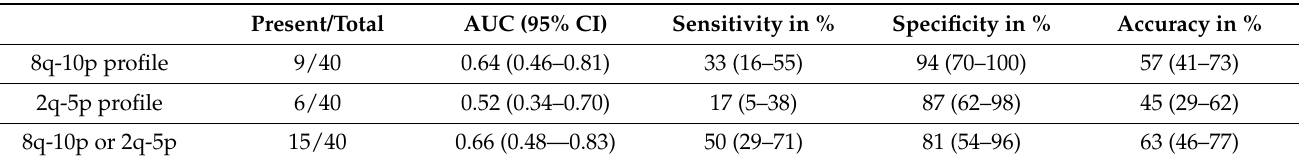
Table 2. Diagnostic performance of the chromosomal profiles. AUC = area under the curve; CI = confidence